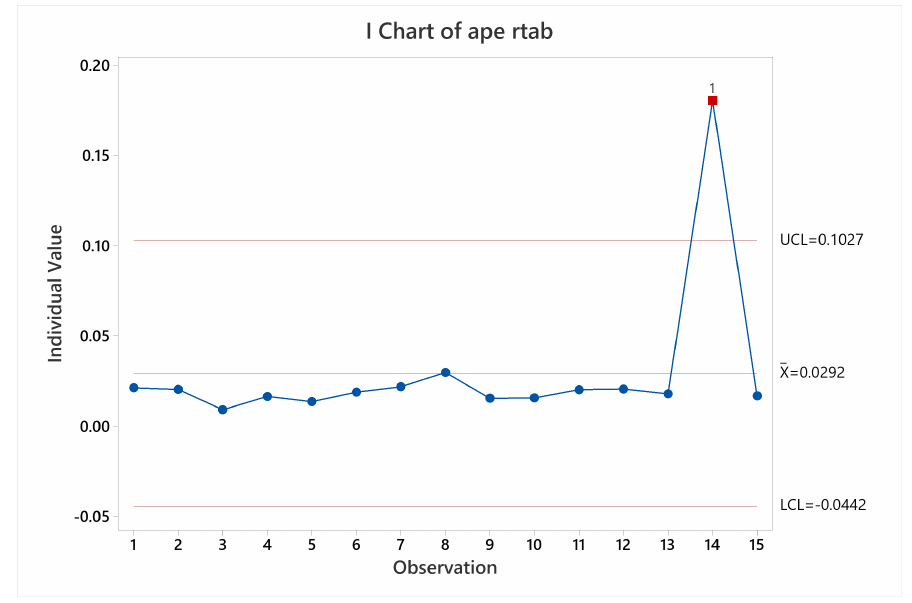
Figure 27. Pose accuracy mean behavior for RTAB-Map.